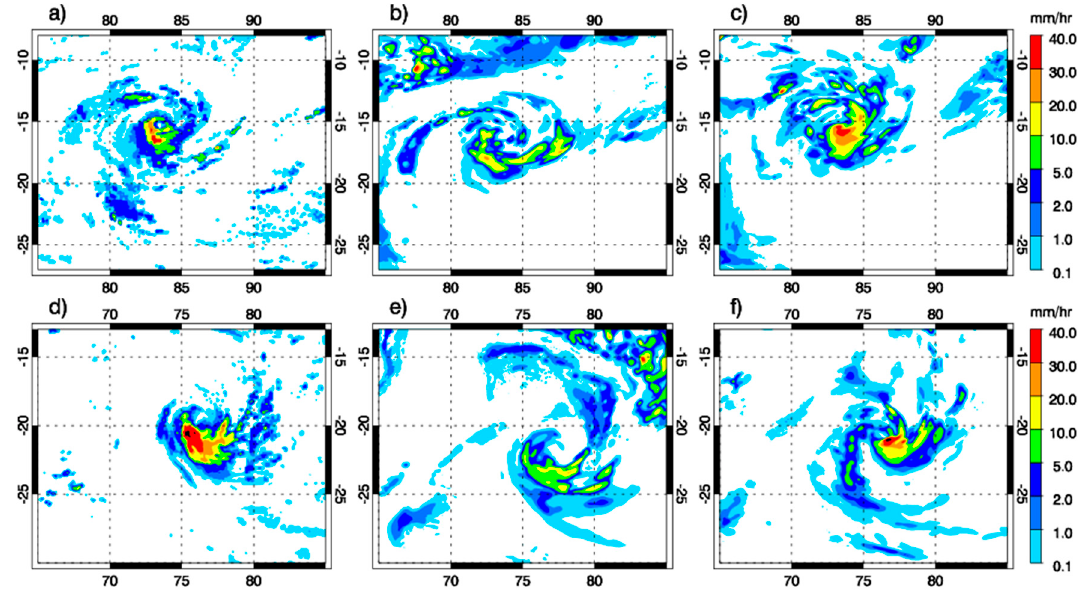
Figure 12. 1-h precipitation around TC Irving from ( a ) IMERG, ( b ) CTRL, ( c ) DA_com at 1500 UTC on 7 January 2018 and ( d ) IMERG, ( e ) CTRL, and ( f ) DA_com at 2100 UTC on 8 January 2018.